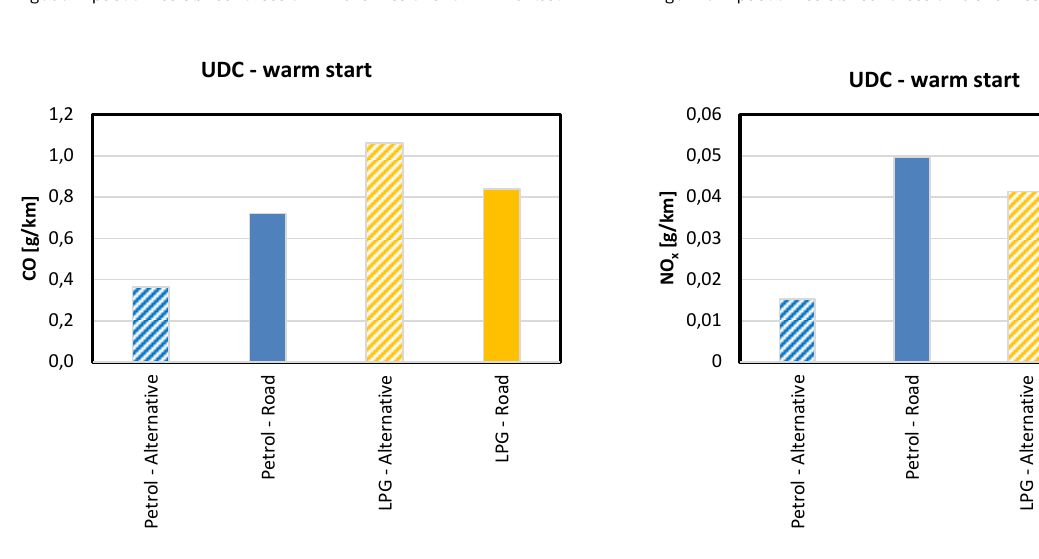
Fig. 10. Impact of resistance forces on CO emissions for UDC phase